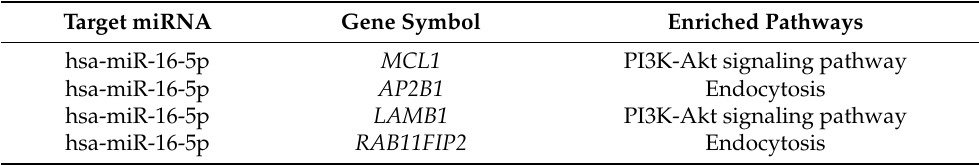
Table 3. Hub genes and their corresponding enriched pathways in the key subnetwork.